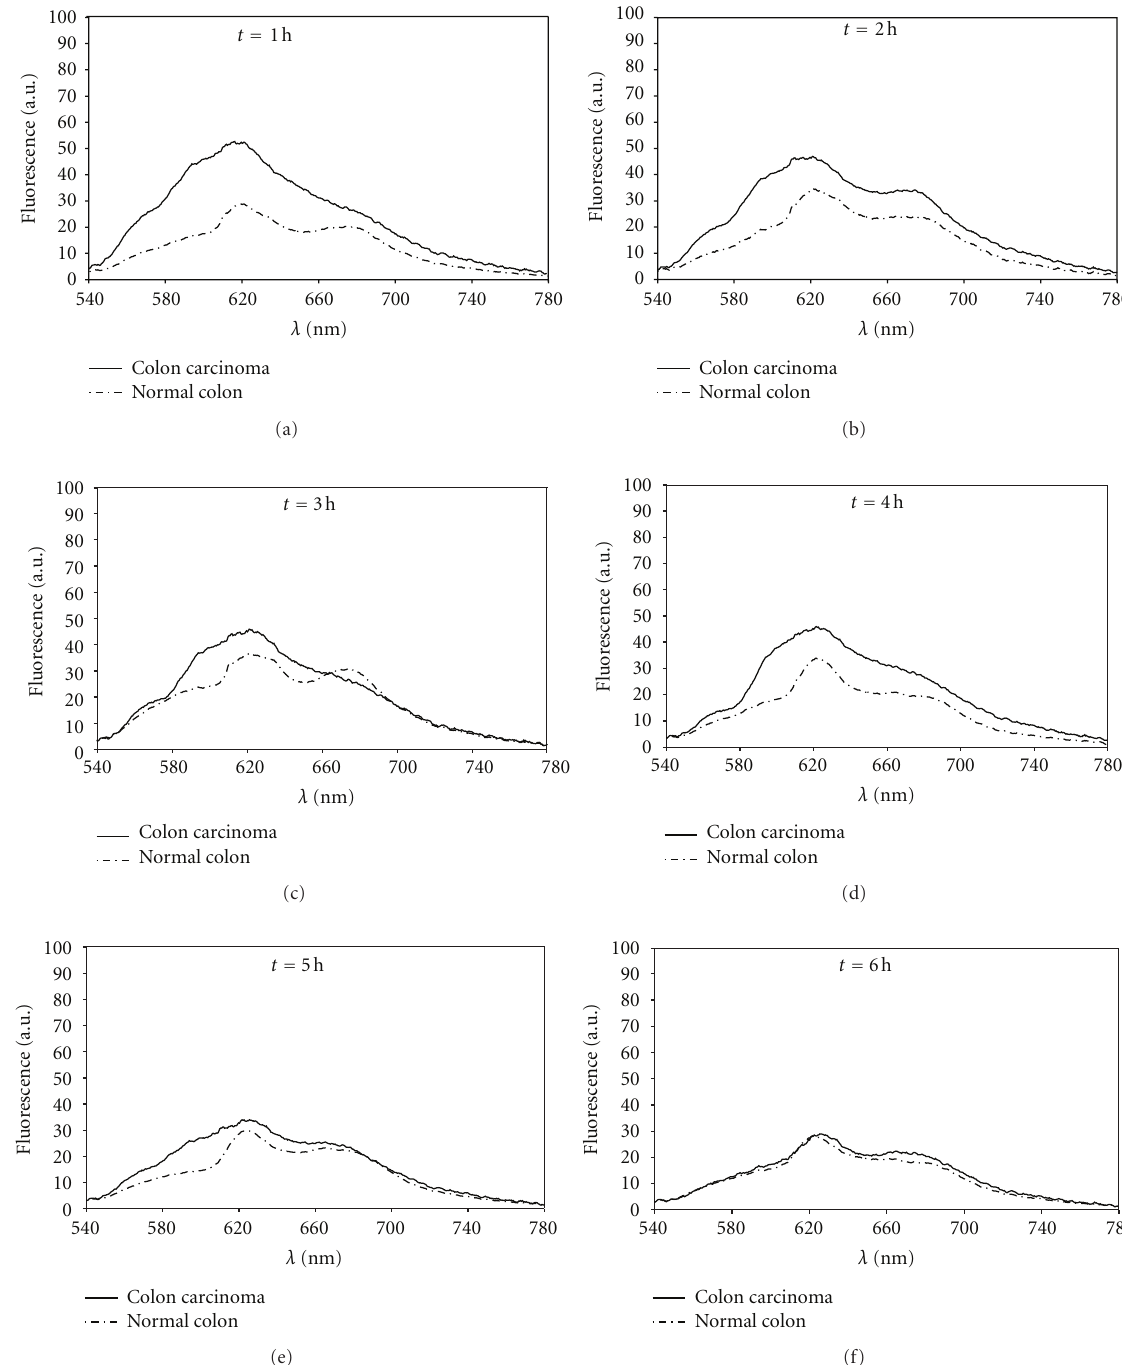
Figure 4: Temporal sequence of colon carcinoma and normal colon fluorescence spectra after intravenous injection of Photogem ((a) = 1 h; (b) = 2h; (c) = 3 h; (d) = 4 h; (e) = 5h; (f) = 6 h).